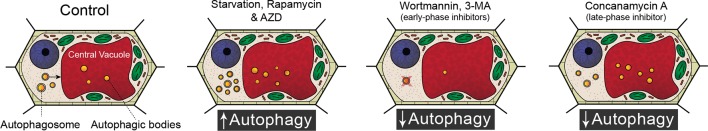
Modulating autophagic flux. Compared to standard control conditions, starvation, rapamycin, and AZD 8055 increase the number of autophagosomes within a cell. Wortmannin and 3-methyladenine (3-MA) disrupt membrane formation and are therefore early phase inhibitors of autophagy. Concanamycin A inhibits the breakdown of autophagic bodies and cargoes in the vacuole.